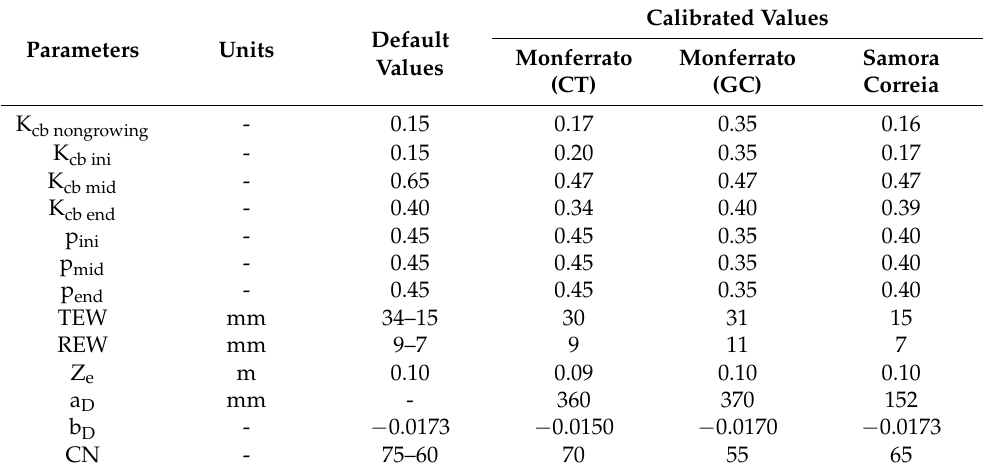
Table 5. Default and calibrated model